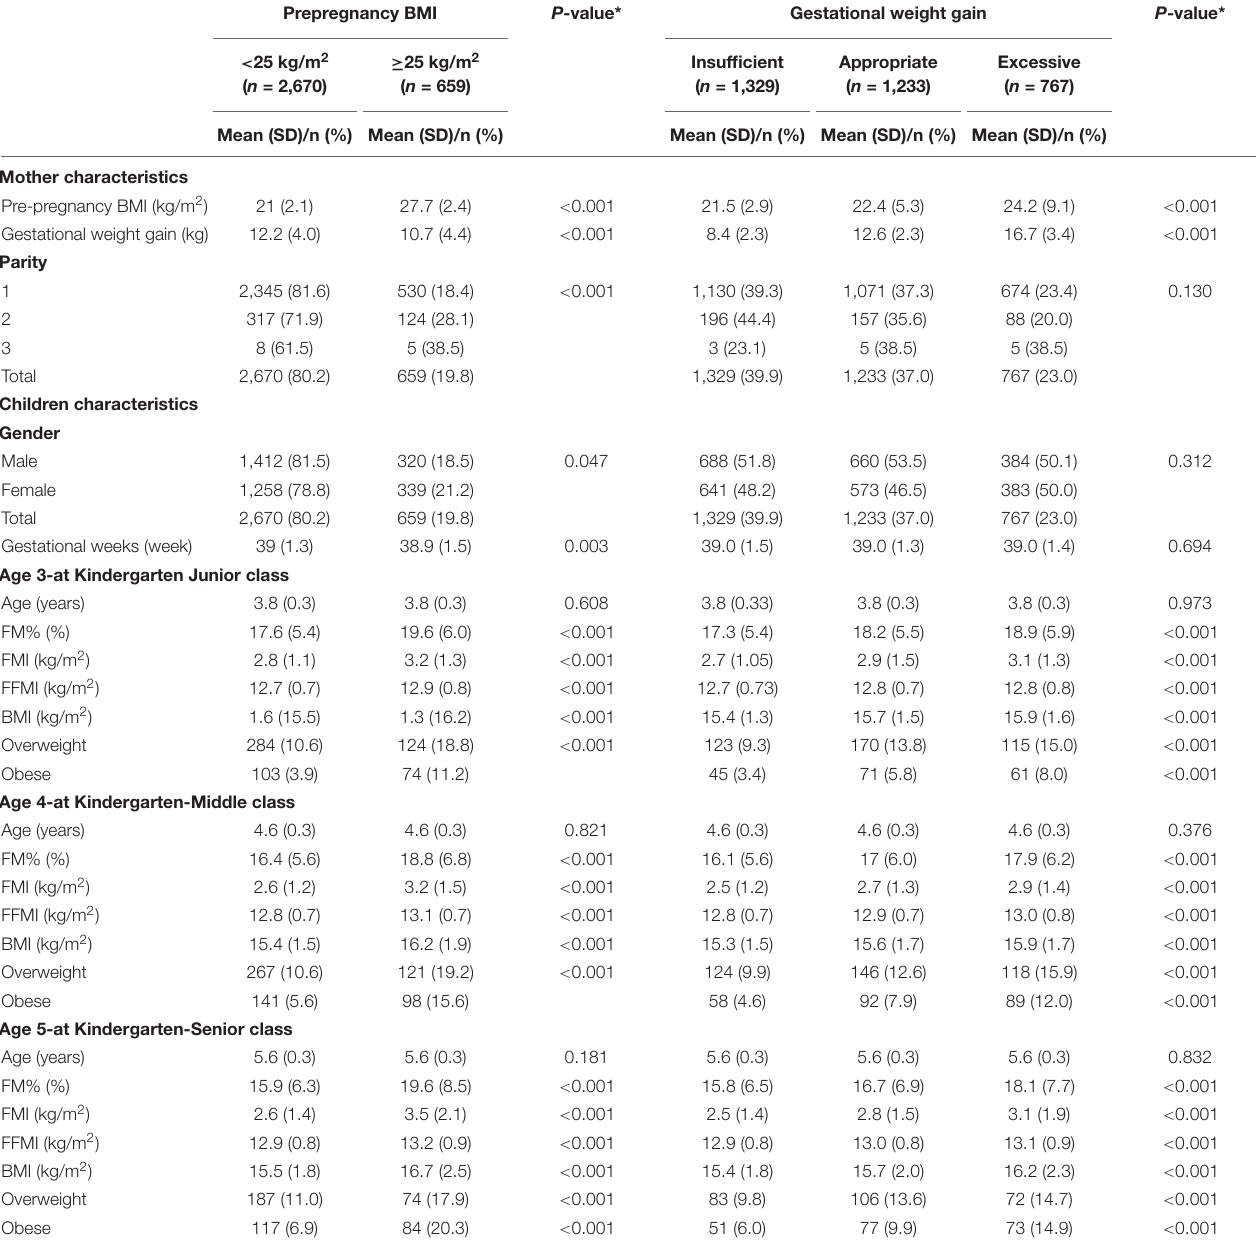
TABLE 2 | Characteristics of the mothers and their preschool offspring in different groups ( n =